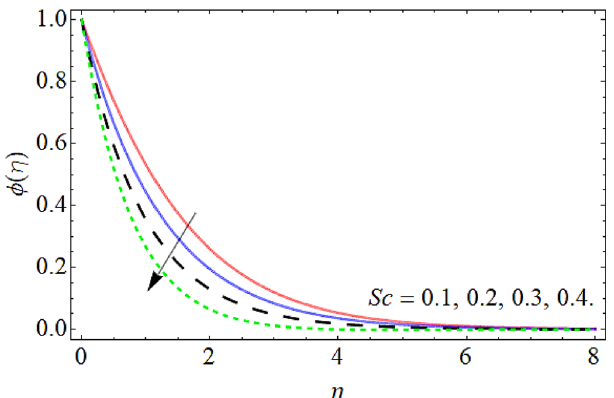
Figure 17. Mass profile versus the Schmidt number Sc .